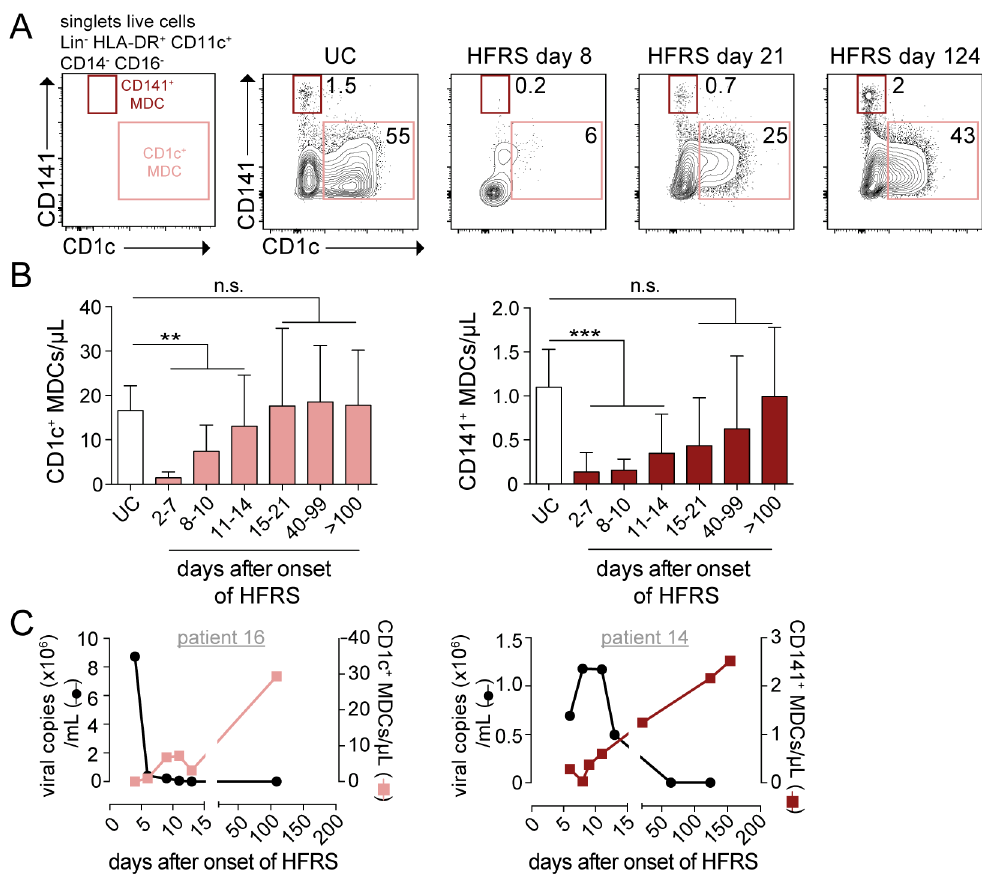
Fig 4. Decreased numbers of CD1c + and CD141 + MDCs in blood during acute HFRS. ( A )Gating strategy for the identificationof CD1c + MDCs (coral) and CD141 + MDCs (maroon)by flow cytometry after gatingout lineage (CD3, CD20, CD56)cells, gating on HLA-DR + , CD11c + cells, and gatingout monocytes (CD14,CD16). Representative flow cytometry plots from one representative UC and HFRS patientare shown. ( B )Mean ± SD absolutenumbers of MDC populationswere evaluatedin longitudinal samplesin HFRS patients in comparison to UC. ( C )Graphs show detectable viral load in plasmameasured by viral RNA quantification from one representative HFRS patient. Virological data (left axis; black line) and absolutenumbers of MDCs (right axis; coloredline)plotted over time from one representative HFRS patient. Differencesin mean absolutenumber of MDCs were assessed using Poisson regression: ** p < 0.01, *** p < 0.001,n.s. not